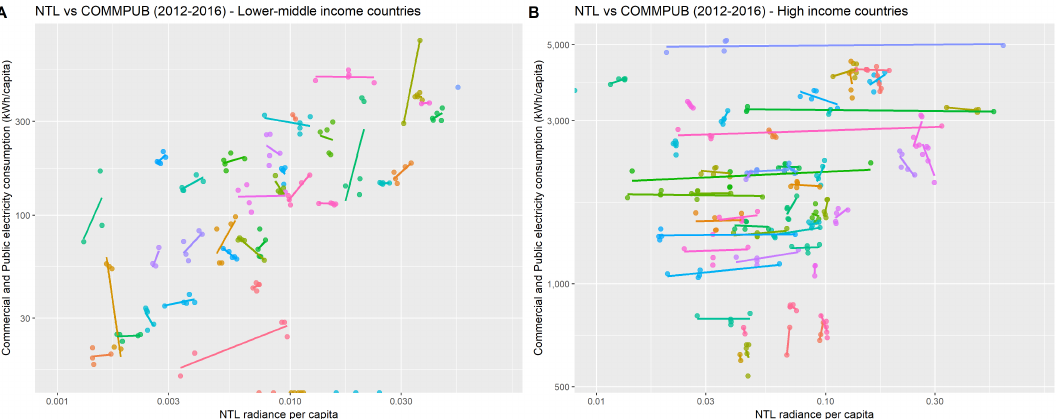
Figure A2. NTL vs. COMMPUB for ( A ) lower-middle income and ( B ) high-income countries (annual values between